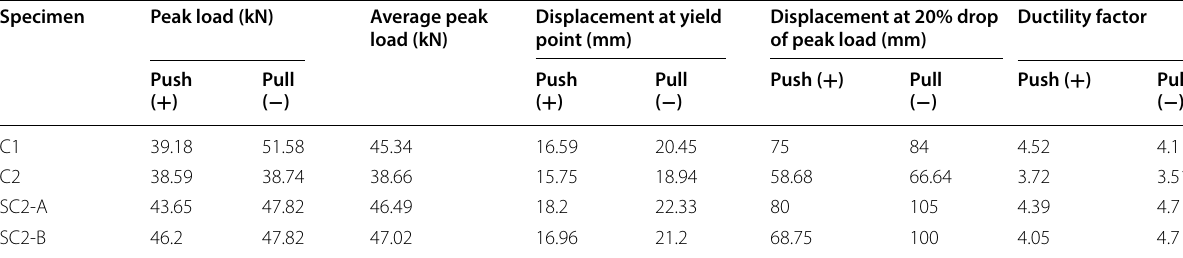
Table 8 Peak load and ductility factor in negative and positive